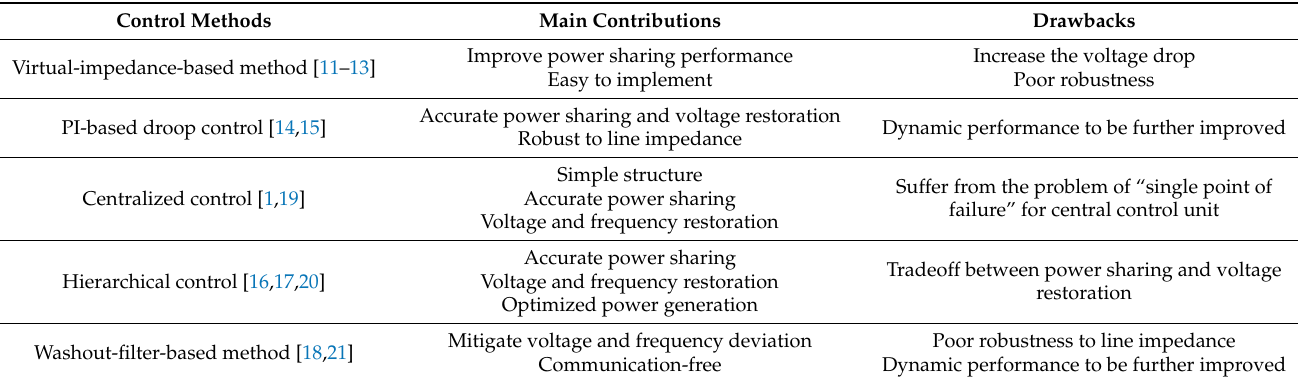
Table 1. Research comparisons of different control